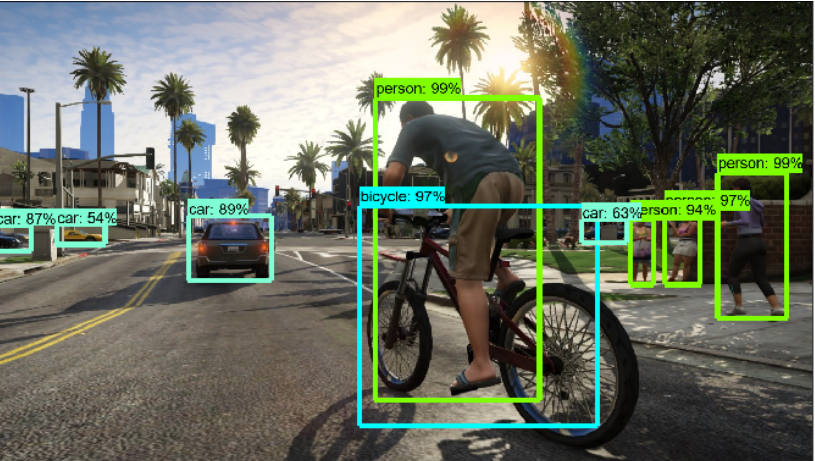
Figure 9. Image analysis through Faster R-CNN: object.